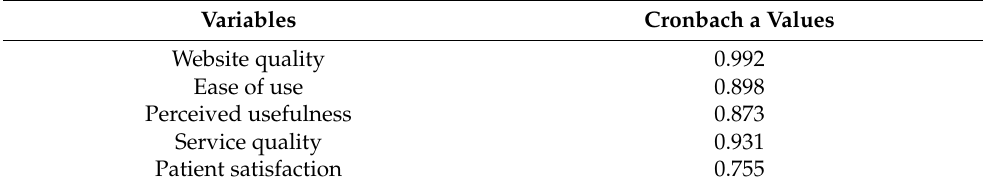
Table 4. Cronbach